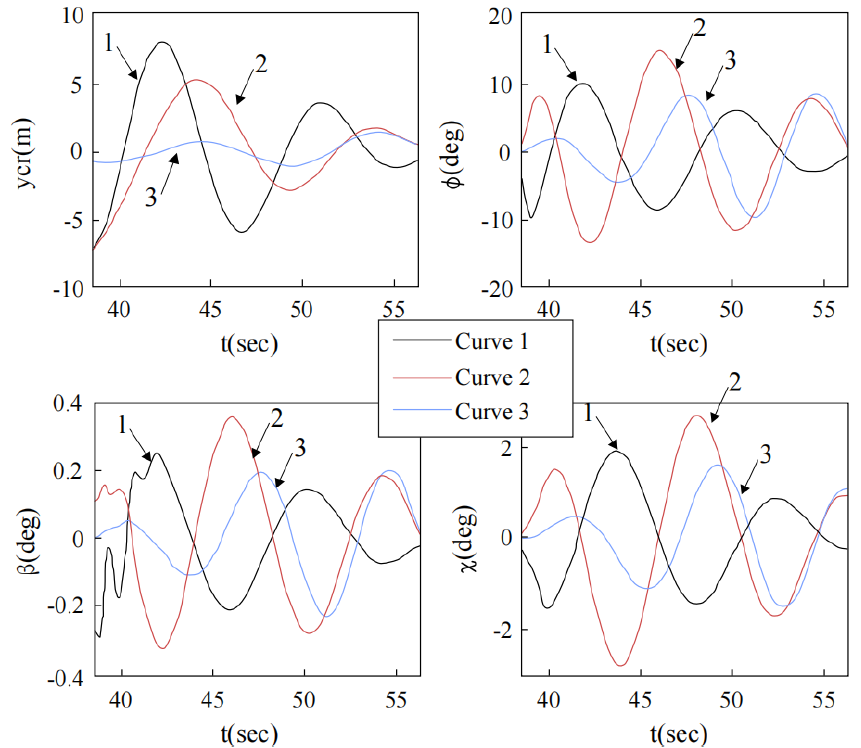
Figure 37. The deck motion compensation curves under inertial tracking strategies with different k values.